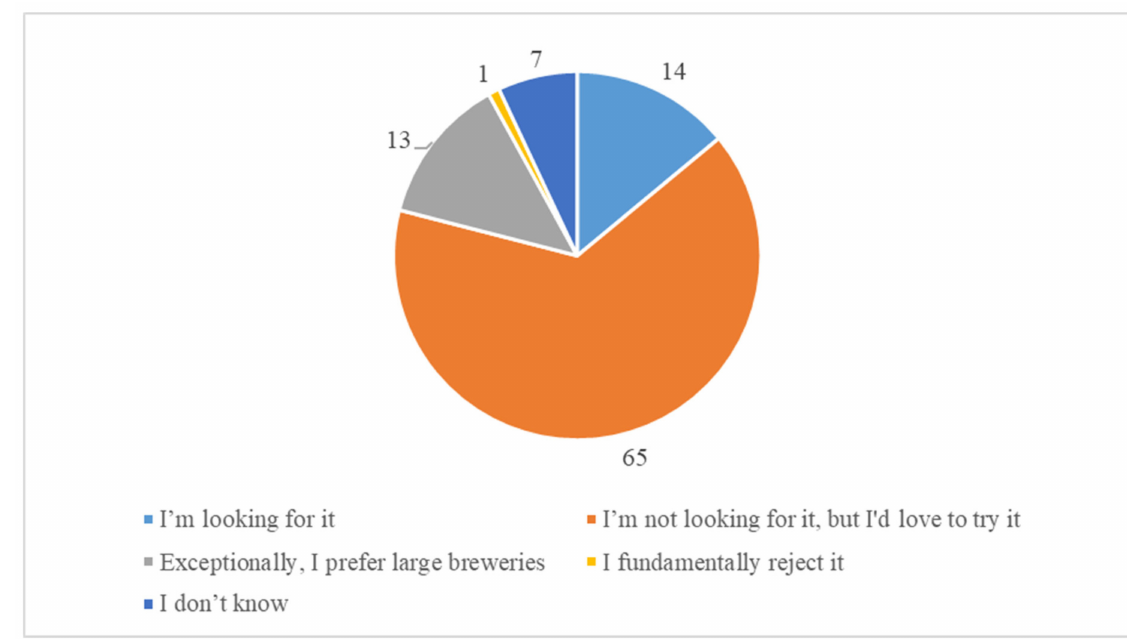
Figure 5. Relationship of consumers to beer from microbreweries in 2017 (in % of respondents-adult citizens of Czechia) [34].